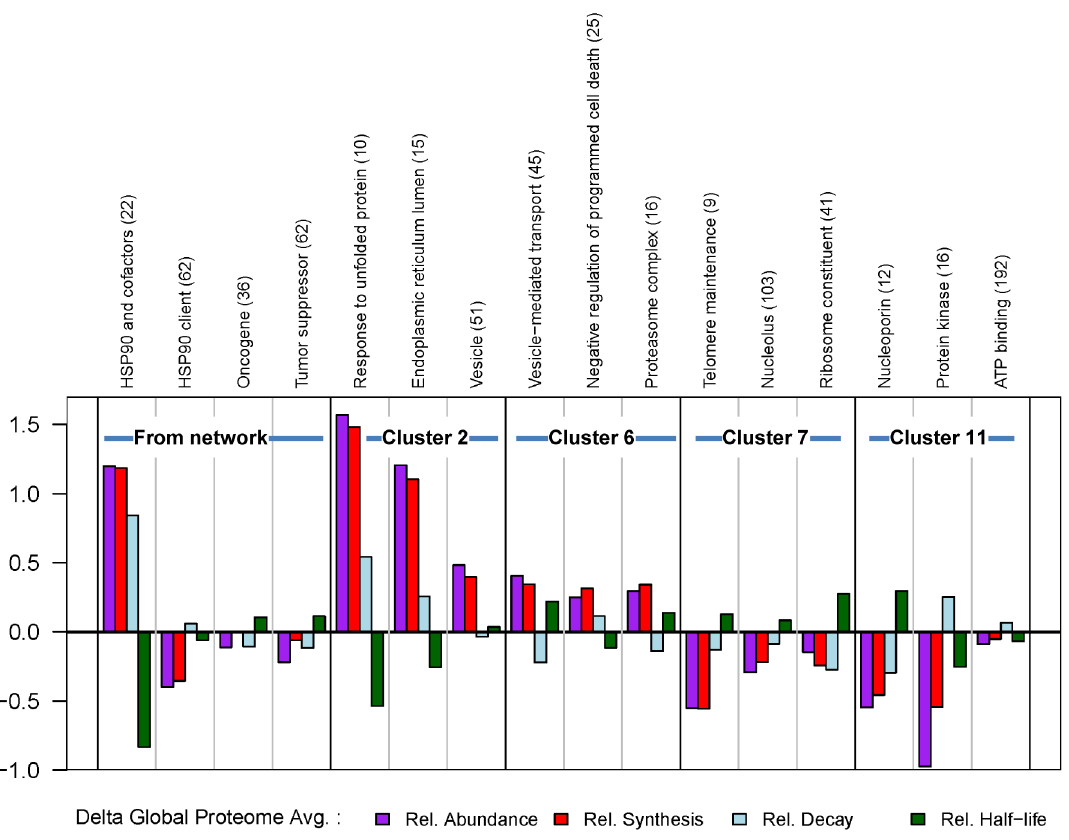
Figure 6. Changes in decay rate constants, synthesis rates, abundance and half-life for protein categories in response to treatment with geldanamycin. Relative average changes in synthesis (log 2 [V s_GA /V s_DMSO ]), decay (log 2 [k d_GA /k d_DMSO ]), abundance (log 2 [p GA /p DMSO ]), and half-life (log 2 [T 1/2_GA /T 1/2_DMSO ]) for selected protein categories. Numbers of proteins in each category are indicated in brackets. All values shown are adjusted for global proteome changes in synthesis and decay by subtracting the median of ratios for the whole dataset (911 proteins).